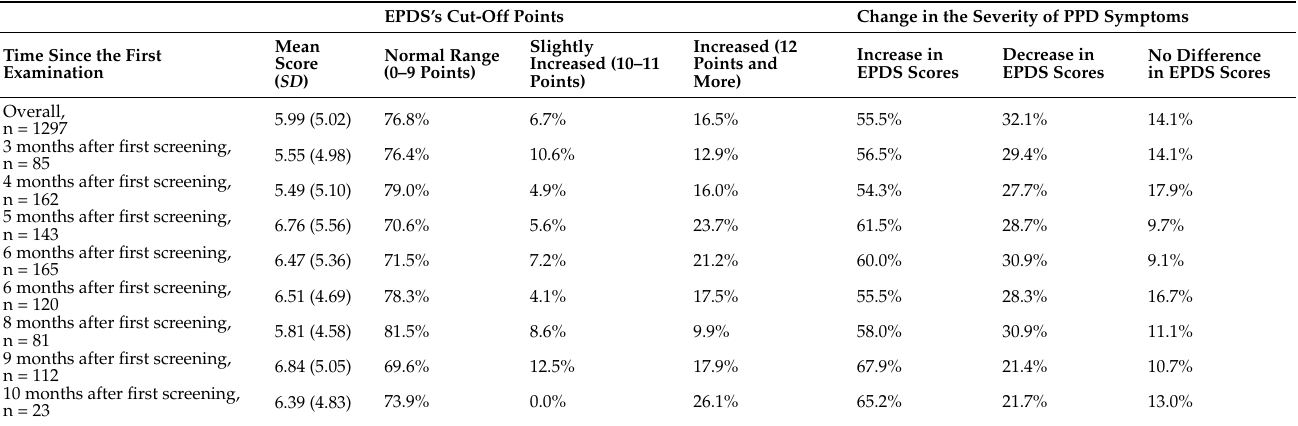
Table 3. Occurrence of the scores obtained by postpartum women in the follow-up screening for PPD with EPDS (regarding the cut-off points and change between the initial assessment and follow-up) in the ‘Next Stop: Mum’ project, n =